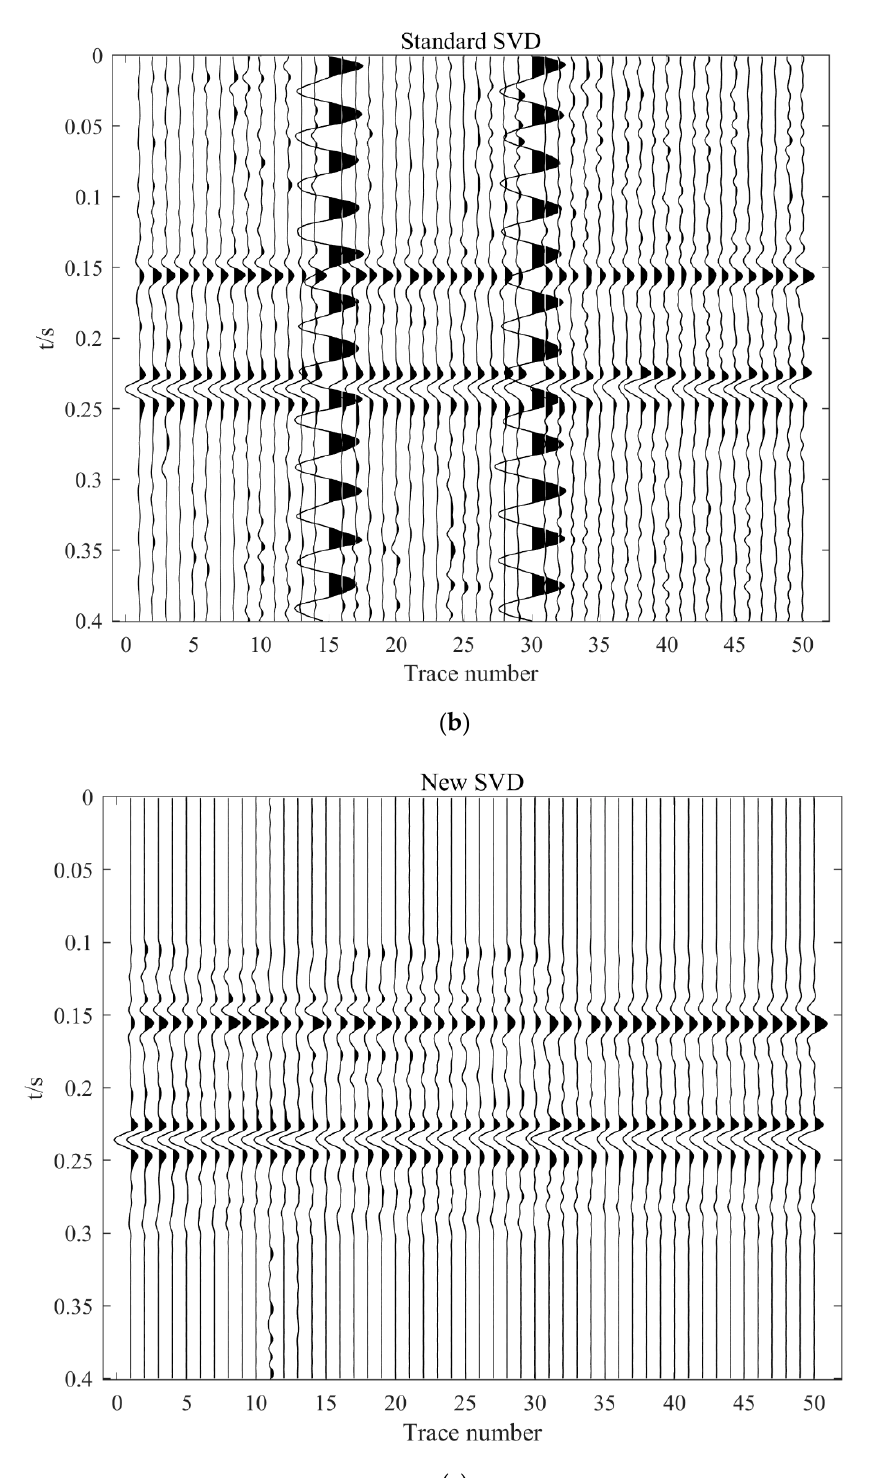
Figure 8. Filtered results were achieved using conventional SVD filtering with ( a ) K = 1 and ( b ) K = 2; ( c ) improved SVD filtering. Table 3. SNR comparison of denoised results from different methods.